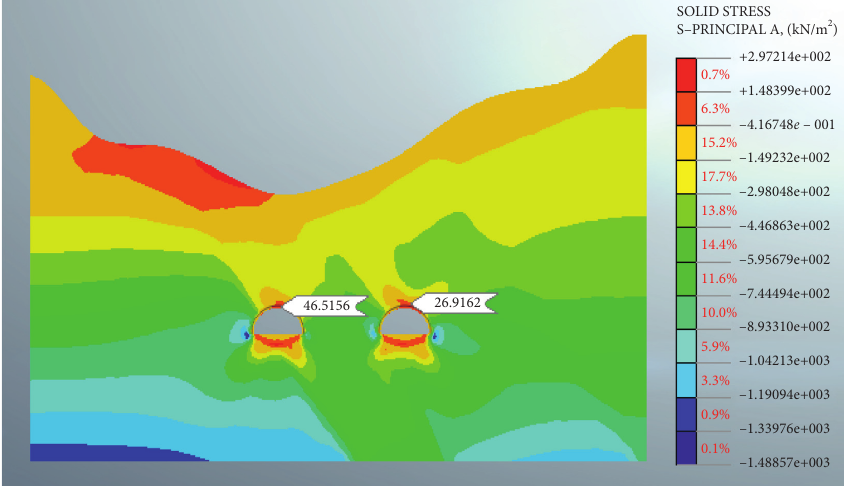
Figure 26: Distribution of small principal stress in surrounding rocks in three-step method.